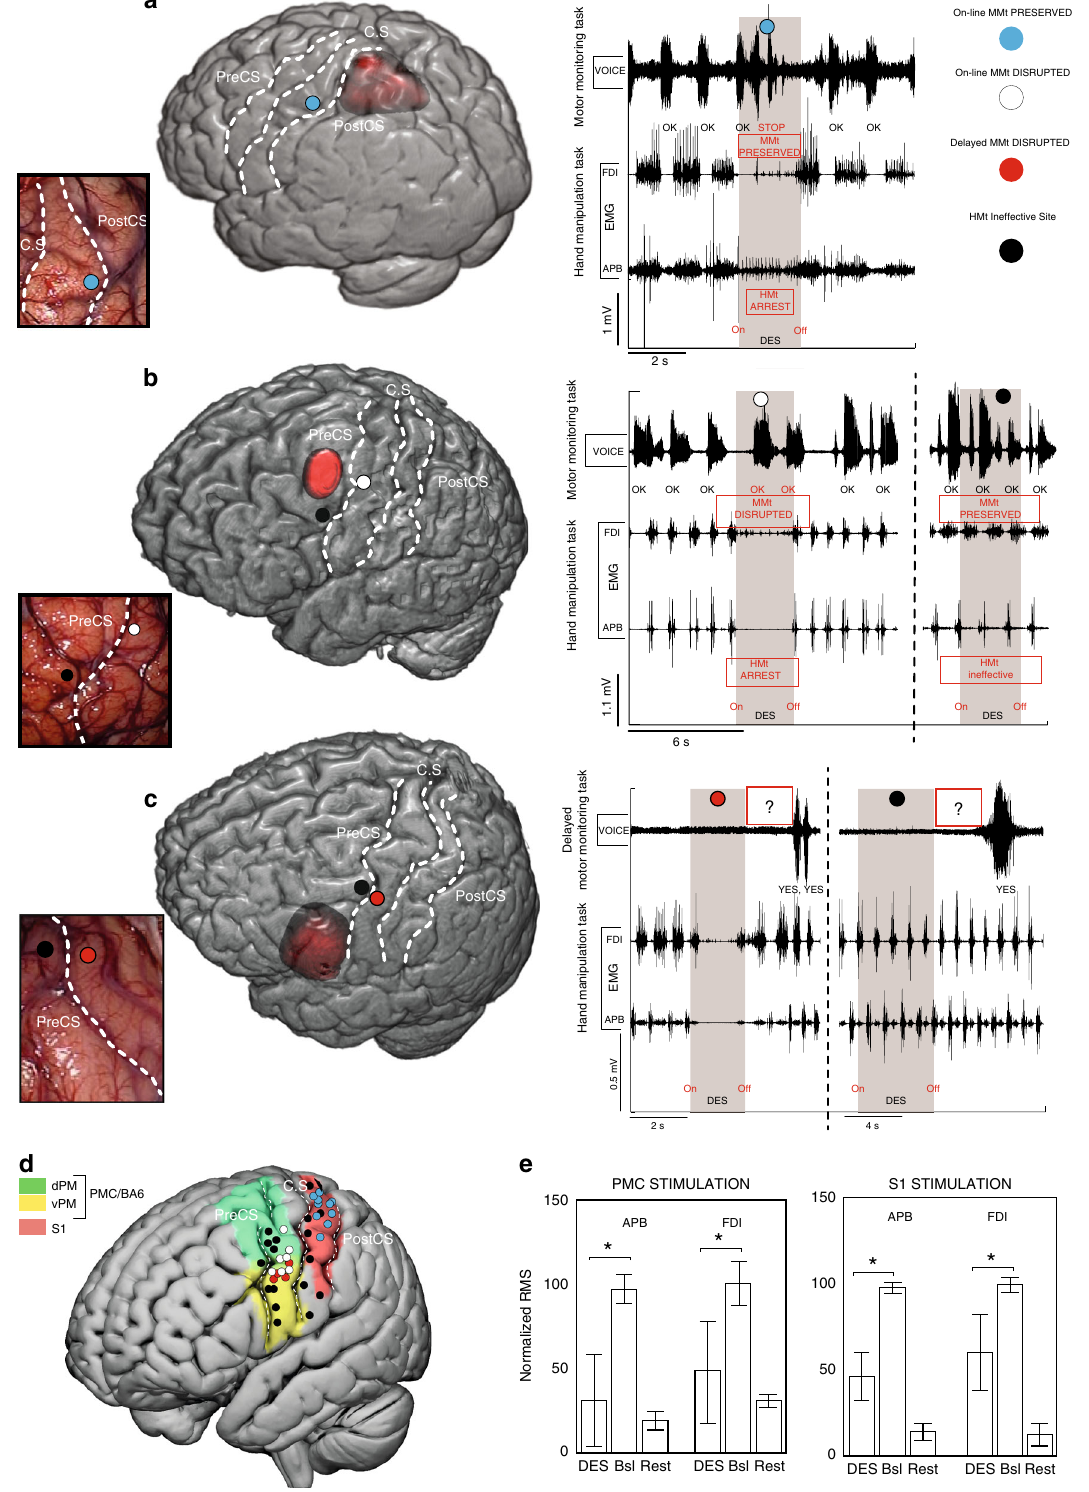
online trials. A signi fi cant association between the percentage of altered trials and the stimulated areas (PMC/S1) was found in both analyses (for both p < 0.001, Fisher ’ s test), showing that altered motor monitoring speci fi cally occurred only during PMC stimulation.